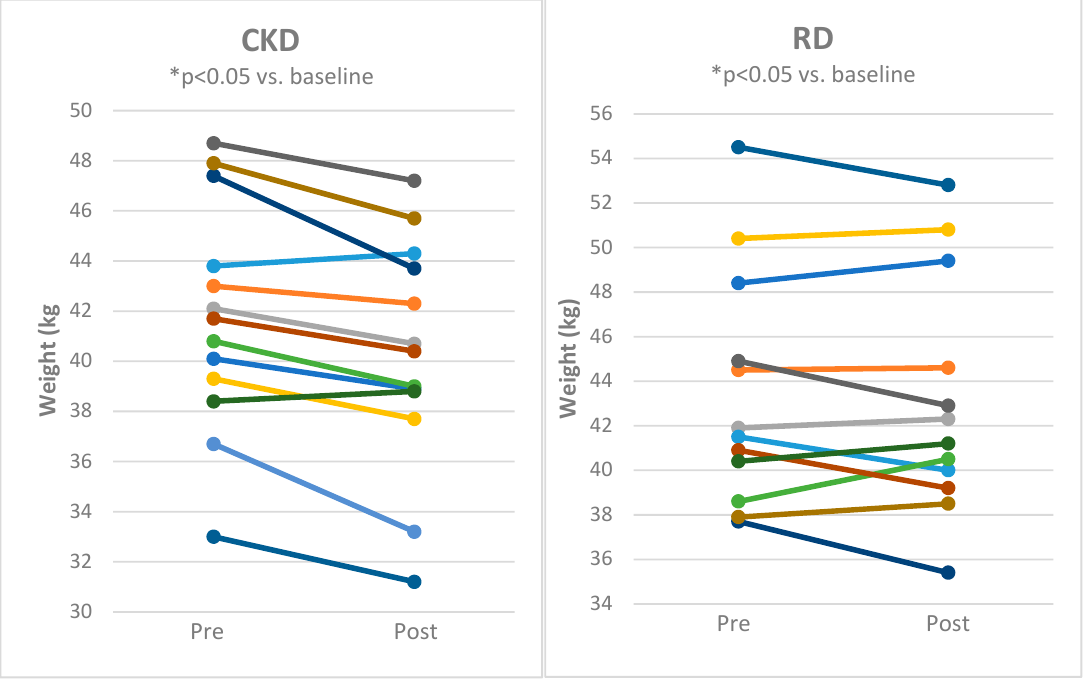
Figure 3. Individual responses of lean body mass for subjects before and after 8 weeks of cyclical ketogenic reduction diet (CKD) and nutritionally balanced reduction diet (RD). Statistical significance is from paired t-test * p < 0.05 vs. baseline.